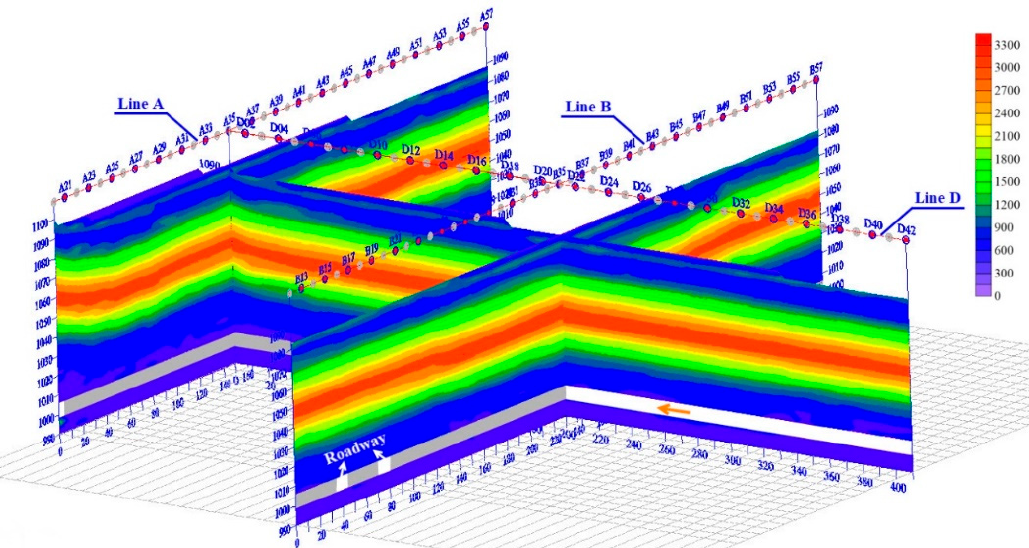
Figure 6. The apparent resistivity contour of overburden before mining.